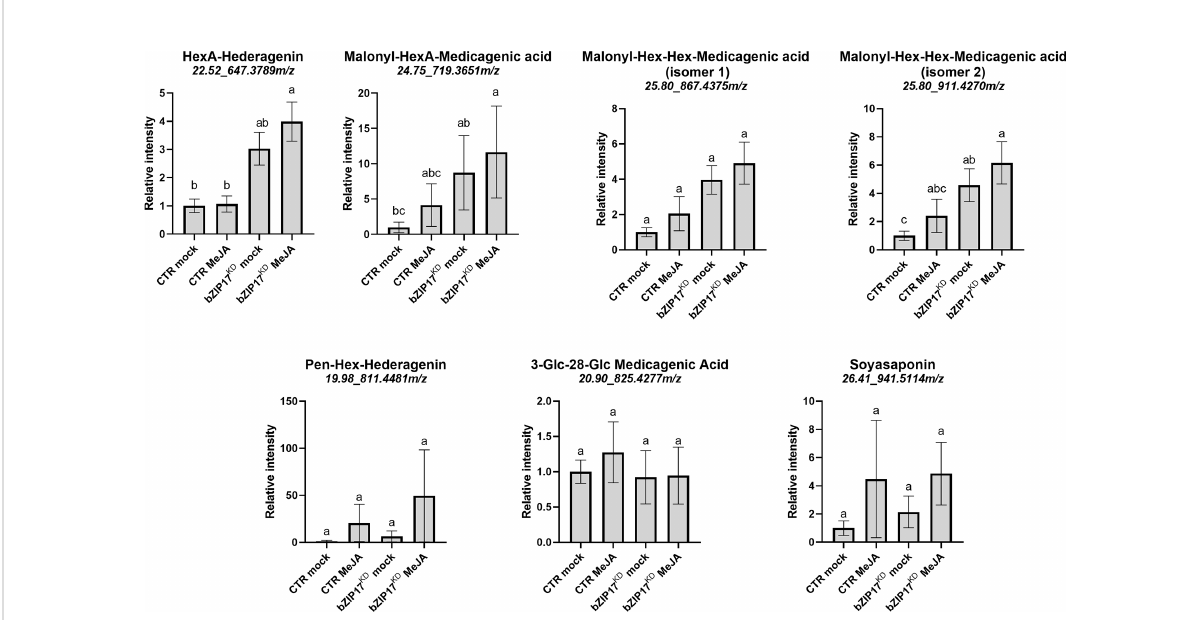
FIGURE 5 Silencing of bZIP17 enhances the accumulation of TS in M. truncatula hairy roots. Relative accumulation of TS in mock- and MeJA-treated control (CTR) and bZIP17 KD hairy roots. Values on the y axis correspond to fold changes relative to the average of the mock-treated control lines. Intensity values were transformed, scaled and analyzed by two-way ANOVA (p ≤ 0.01), categories refer to Tukey ’ s post-hoc test (p < 0.05). For each of the TS, the identity, retention time and m/z value is indicated on top. The small letters represent the categories that refer to Tukey ’ s post-hoc test (p < 0.05). They indicate signi fi cant differences between